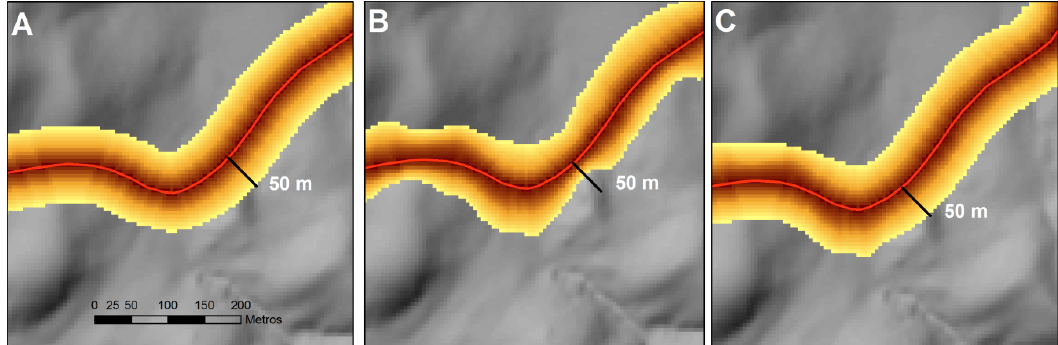
Figure 5. Ability of people to penetrate the forest environment (induced hazard). ( A ) Length provided per Euclidean distance. ( B ) Length provided per travel time estimation. ( C ) Selection of maximum length provided per A or B.